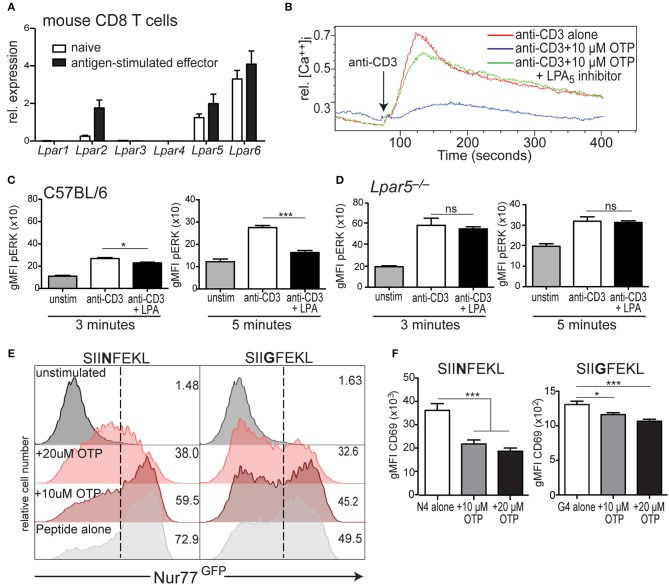
LPA5 is responsible for negatively regulating murine CD8 T cell early TCR signaling. (A) Expression of Lpar1-6 by naïve and antigen-stimulated OT-I CD8 T cells. Data is accumulative for 3–4 analyses of CD8 T cells purified from naïve or peptide-activated OT-I splenocytes. (B) Intracellular calcium levels over time in murine CD8 T cells stimulated with anti-CD3 alone (red) or anti-CD3 in the presence of 10 μM OTP (blue) or in the presence of 10 μM OTP and the small molecule UA-02-85 LPA5 inhibitor (LPA5i; green). (C) C57BL/6 and (D)
Lpar5−/− CD8 T cells were left untreated (gray) or treated with biotin-coupled anti-CD3 and subsequently stimulated with avidin for either 3 min (left) or 5 min (right) alone (white) or in the presence of 10 μM LPA (black) and intracellular pERK levels measured by flow cytometric analyses. Data are representative of technical triplicates and similarly observed in 4 independent experiments. *p < 0.05; ***p < 0.0005; ns, not significant as determined by one-tailed paired Student's t-test. (E) Nur77GFP expression by WT OT-I Nur77GFP CD8 T cells stimulated with 2 μM of SIINFEKL (N4; left panels) or SIIGFEKL (G4; right panels) peptide for 24 h alone (light gray) or in the presence of 10 μM OTP (dark red) or 20 μM OTP (light red). Data are representative of two independent experiments. (F) CD69 expression by OT-I CD8 T cells stimulated with 2 μM of SIINFEKL (N4; left panels) or SIIGFEKL (G4; right panels) peptide alone (white) or in the presence of 10 μM (gray), 20 μM (black) OTP. *p < 0.05; ***p < 0.005 as determined by one-tailed paired Student's t-test. Data is accumulative of two independent experiments done with technical triplicates.